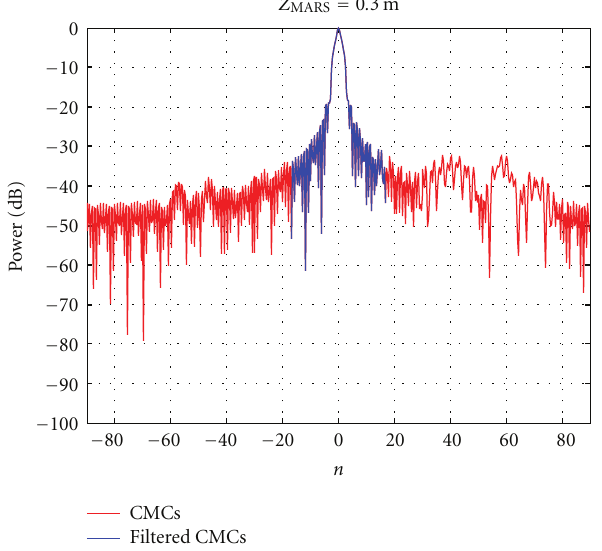
Figure 11: Equivalent CMCs with AUT displacement of 30cm.